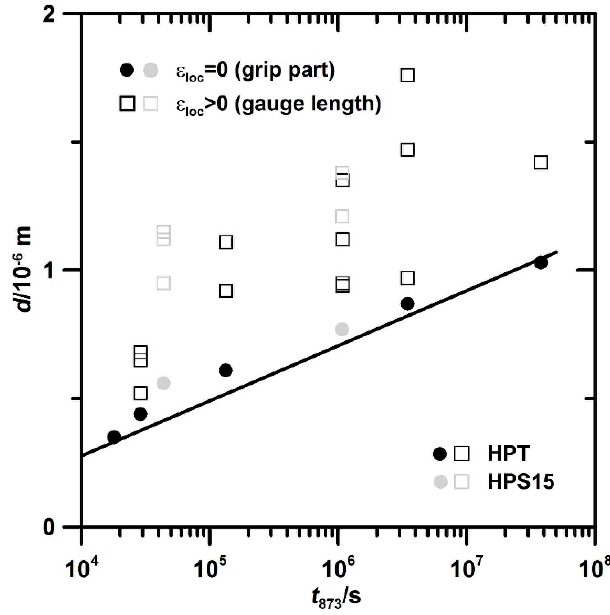
Figure 13. Grain structure of HPT with HAGB lines for θ > 15° after creep at σ 0 = 50 MPa for 10,538 h ( a ) in the grip part and ( b ) in the gauge length at ε = 0.08. The stress axis is horizontal.